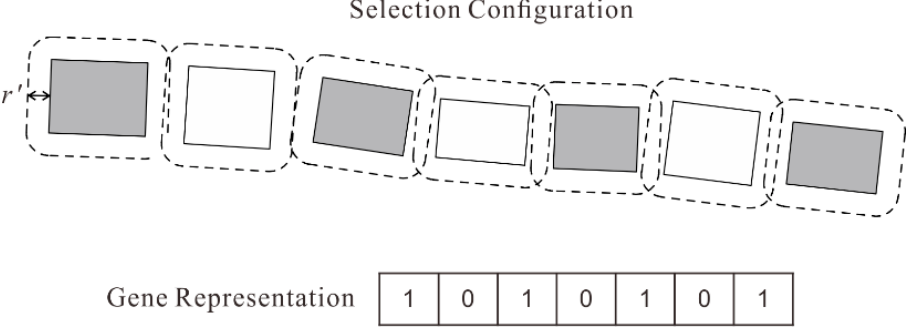
Figure 6. Encoding for a group of aligned buildings. r ’ is half the minimum distance threshold for detecting conflicts.